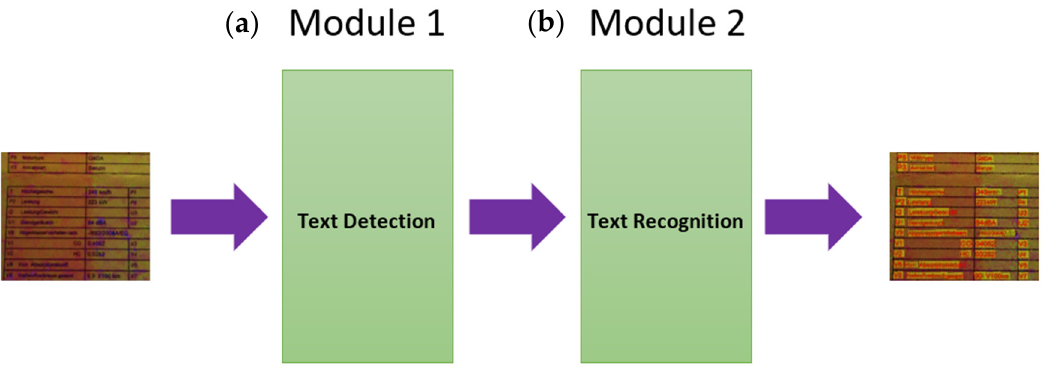
Figure 4. Our new global model, composed of ( a ) text detection (Module 1) and ( b ) text recognition (Module 2).